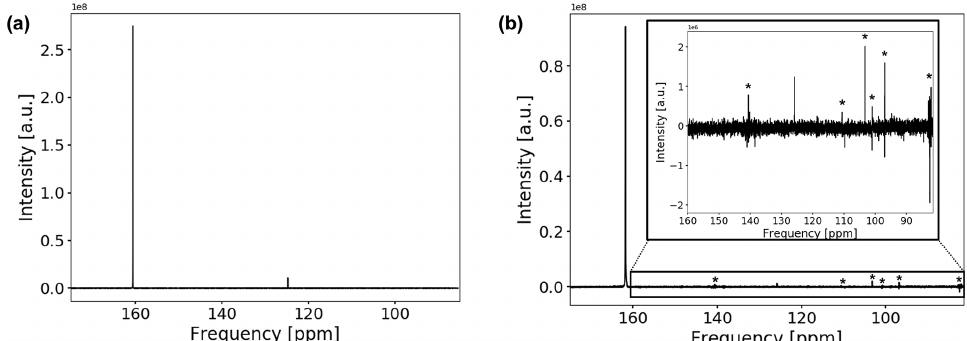
Figure 7. 13 C spectrum of the CO 2 -saturated electrolyte without (a) and with (b) electrodes. Measurements with electrodes include con- nection cables and a powered potentiostat but no shielding. The peak positions of bicarbonate and solvated carbon dioxide are at 160.7 and 124.7ppm, respectively. Peak positions are shifted downfield by about 1.1ppm when the conductive components are introduced. The spec- trum in (b) suffers from increased noise as well as from external RF signals, which are comparable in intensity to the CO 2 signal. External RF signals have been marked with (*).